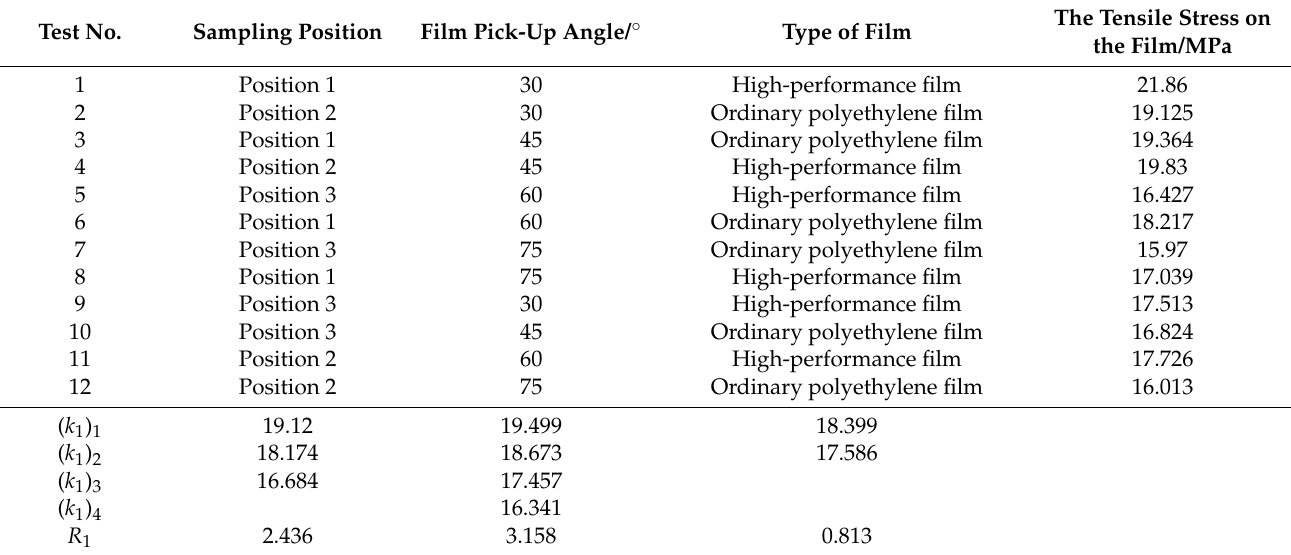
Table 4. Test plans and results.